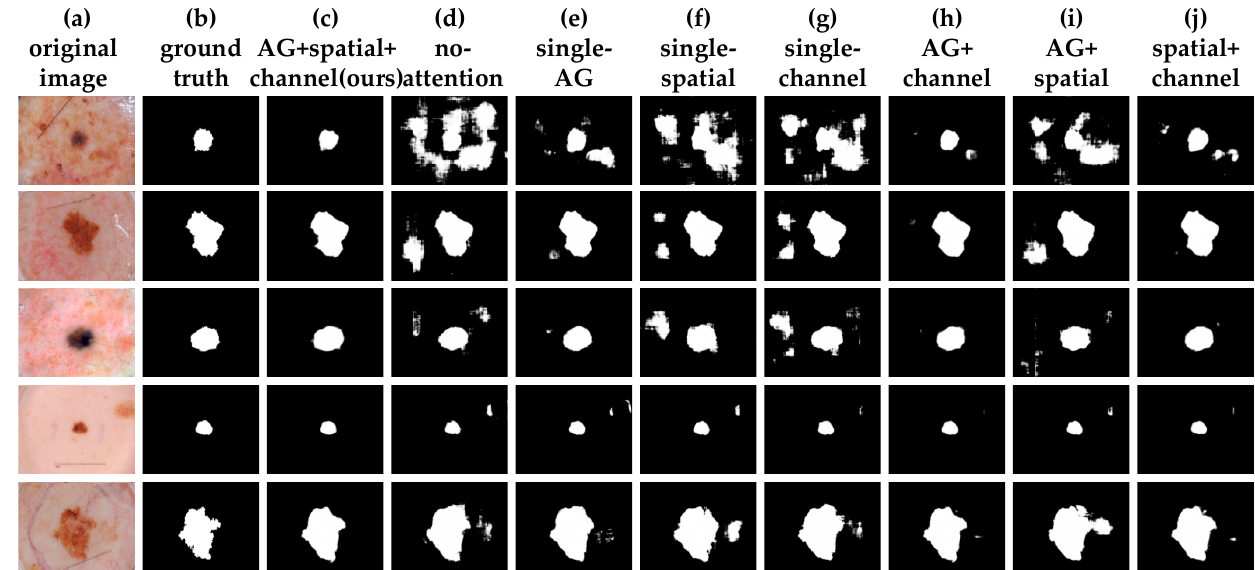
Figure 9. Visualization results of an ablation experiment. From left to right are the original image of the dermoscope, skin lesion segmentation ground truth, AG+spatial+channel(ours), no-attention, single-AG, single-spatial, single-channel, AG+channel, AG+spatial and spatial+channel.